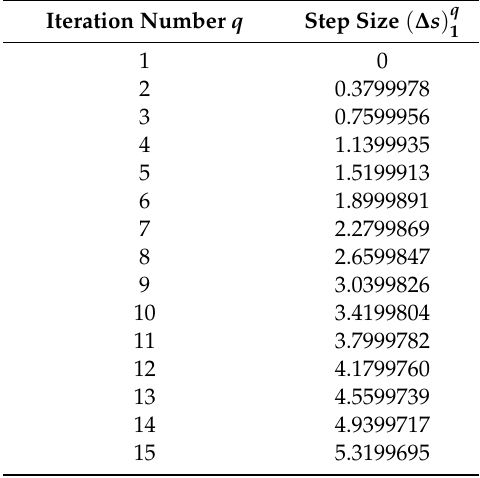
Table A1. Step size for each point between 1th and